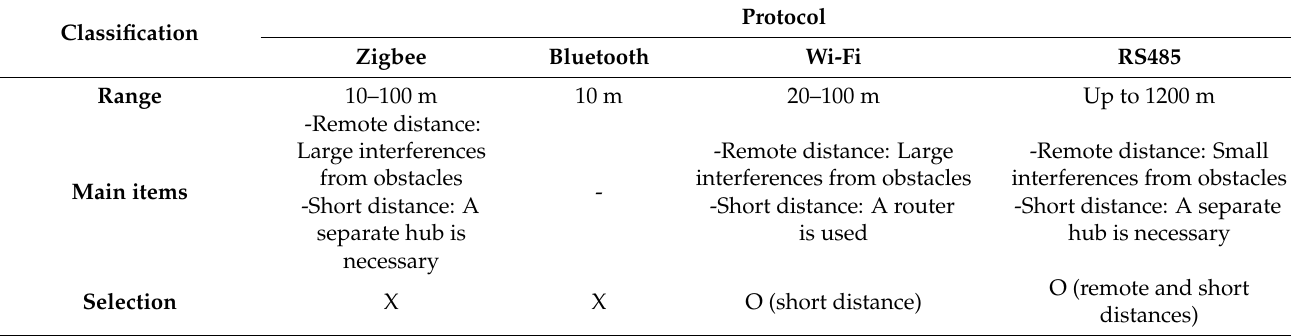
Table 3. Selection of communication method for the construction site PM measuring